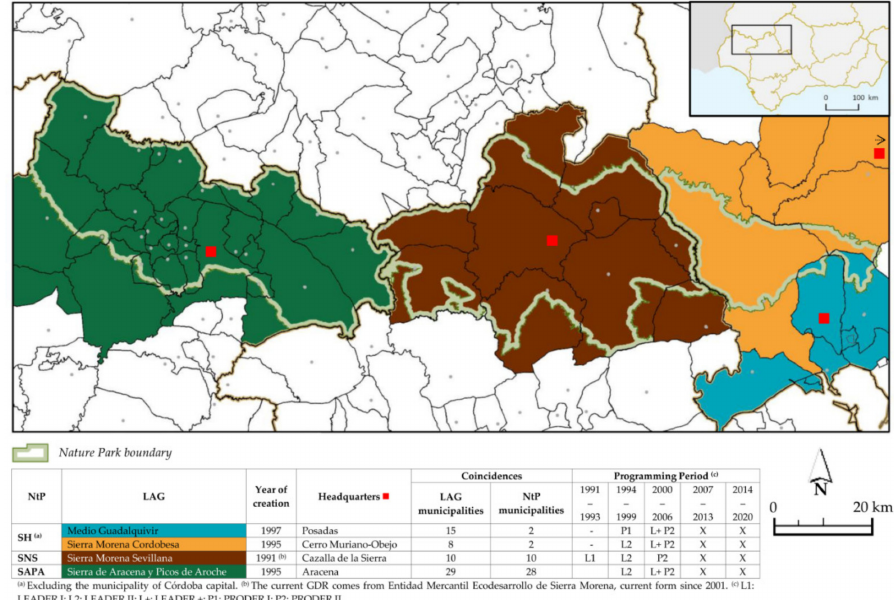
Figure 3. LAGs in the scope of the study. Source: [88]. Authors’